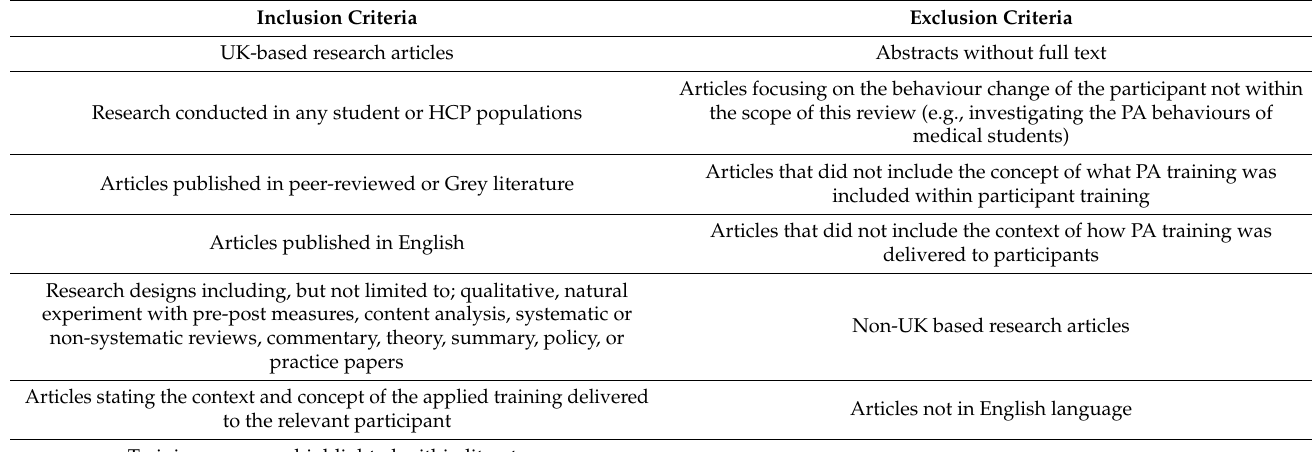
Table 1. Inclusion and exclusion search criteria for electronic database search.